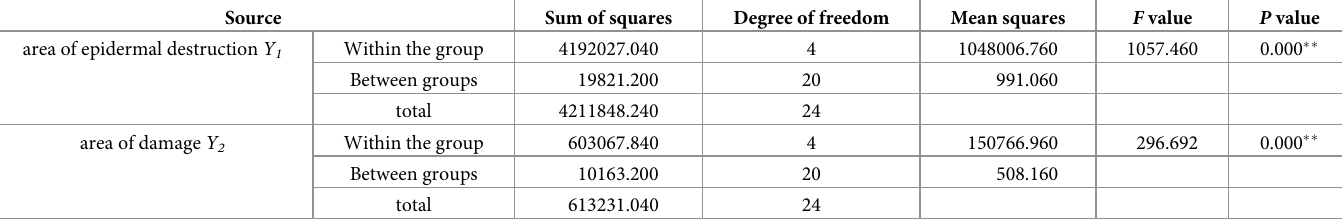
Table 8. Variance analysis of the influence of sweet potato chunk size on each